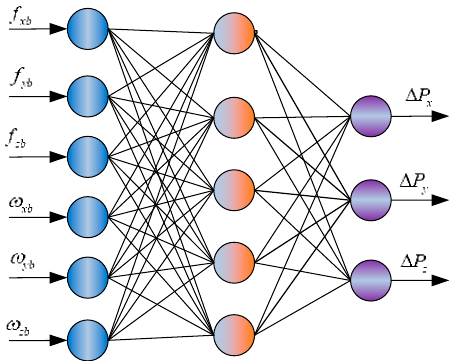
Figure 2. Input and output of a radial basis function network.